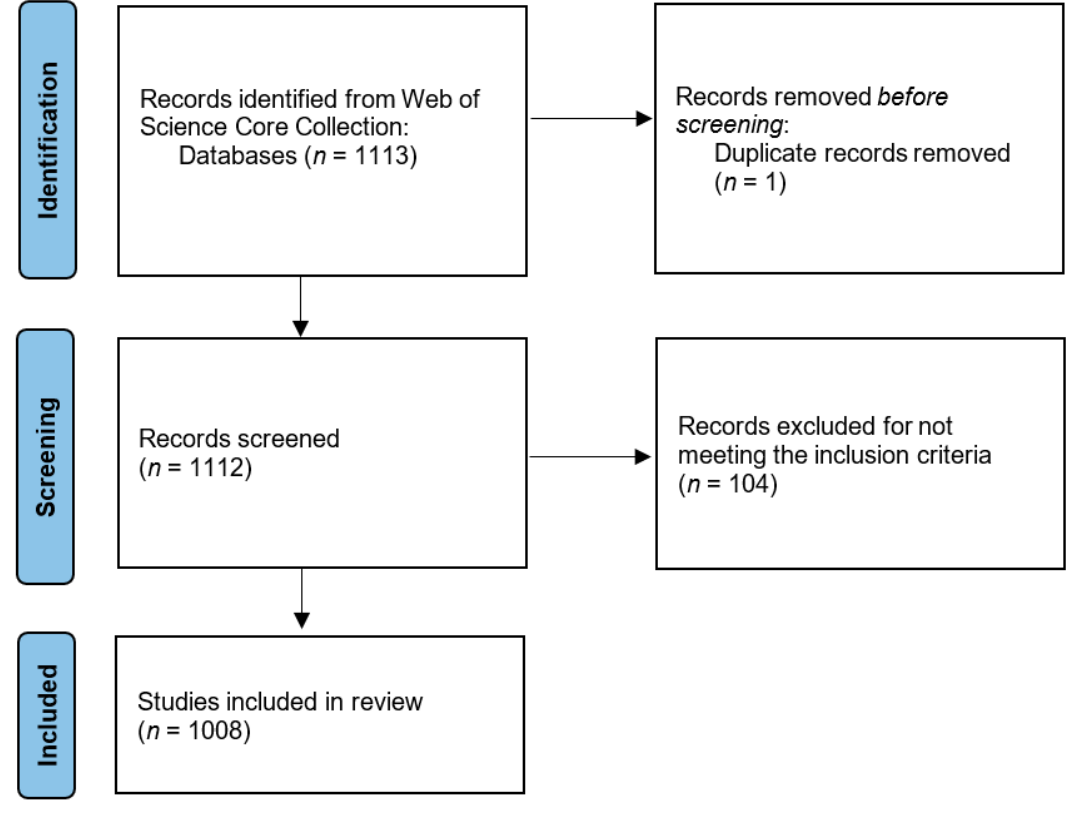
Figure 1. PRISMA Flow Diagram.